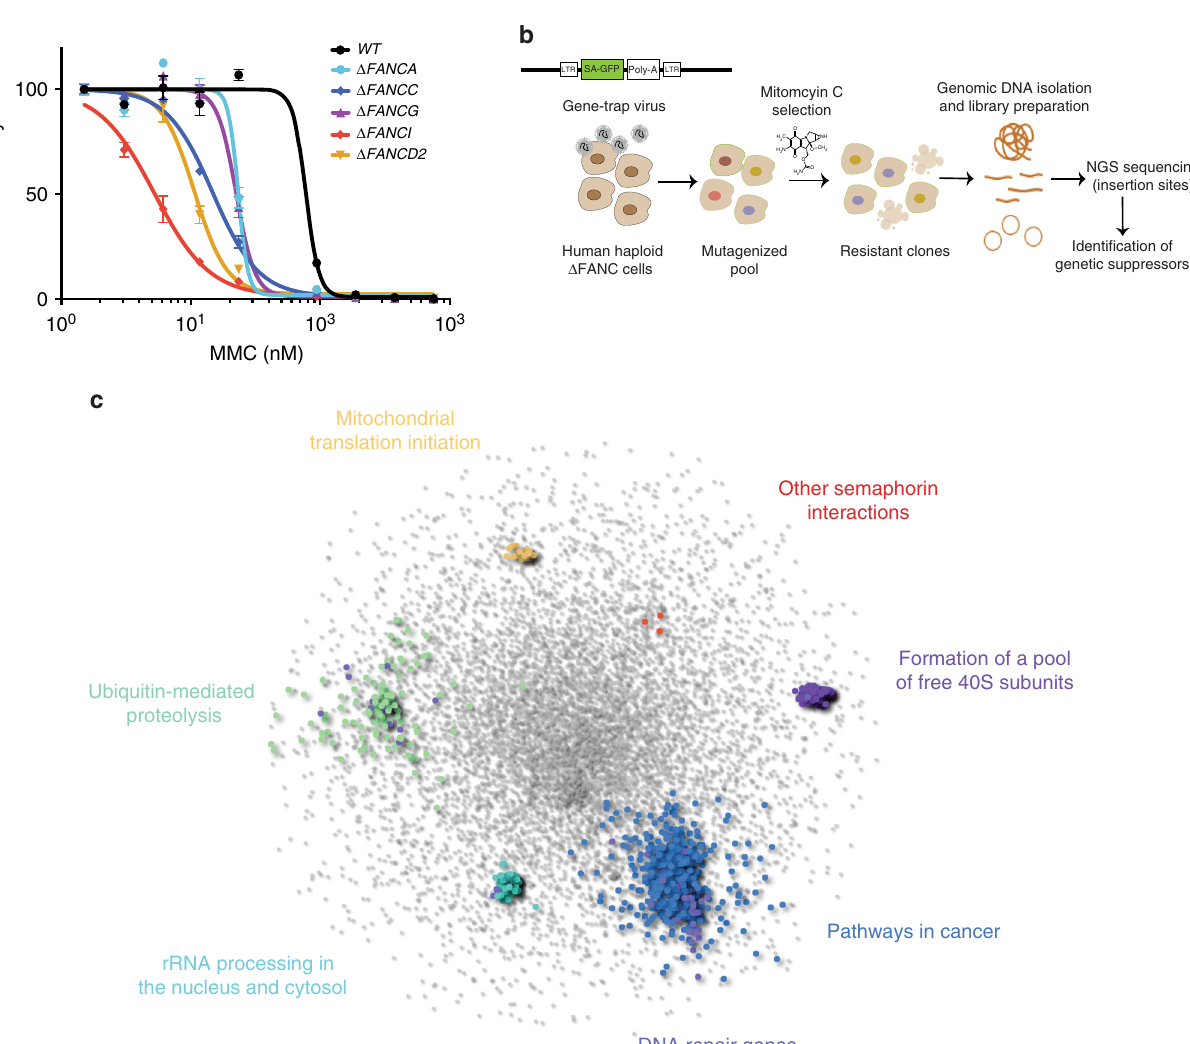
Fig. 1 Genetic screens identify synthetic-viable interactions for FA. a Dose – response of FA-defective HAP1 cell lines to MMC exposure. Cells were treated for 3 days and viability was measured by Cell Titer Glo ® . Error bars indicate S.E.M (standard error of the mean) of triplicates. b Work fl ow for the identi fi cation of genetic synthetic-viable interactions for FA-defective human haploid HAP1 cells following MMC exposure by gene-trap-based insertional mutagenesis. c Protein – protein interaction network analysis reveals pathways signi fi cantly enriched speci fi cally in the FA-de fi cient cells, in response to